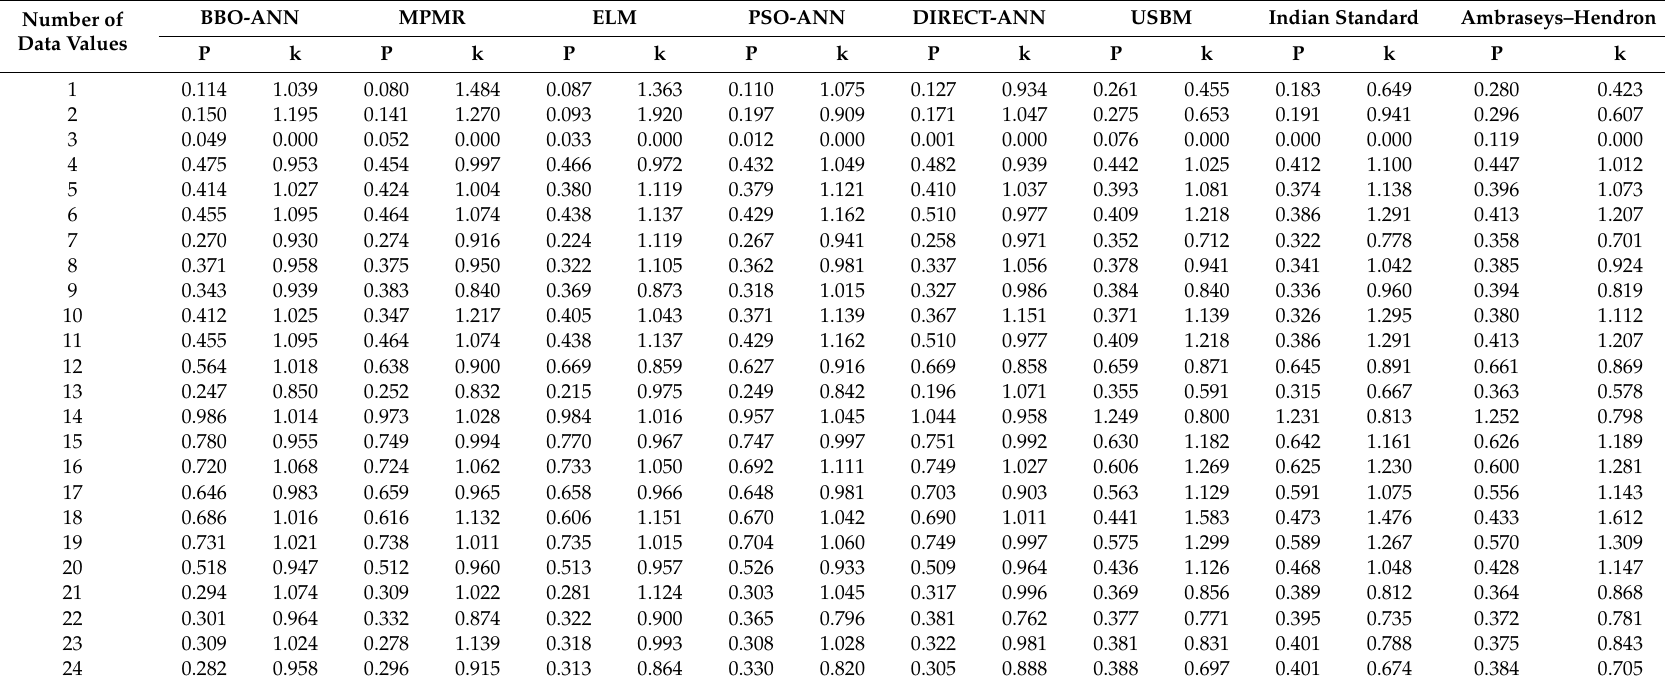
Table 6. Predicted PPV values (normalized) obtained from the models for only the testing